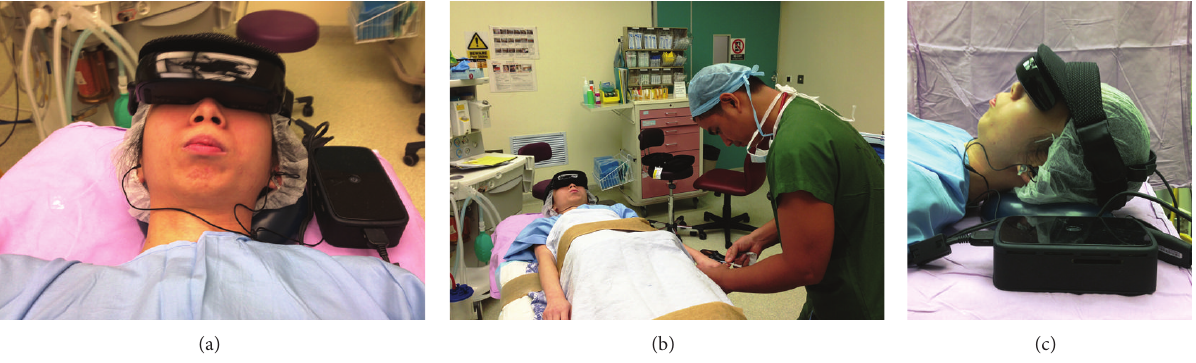
Figure 2: The use of HEADPLAY PCS device during intravenous cannula